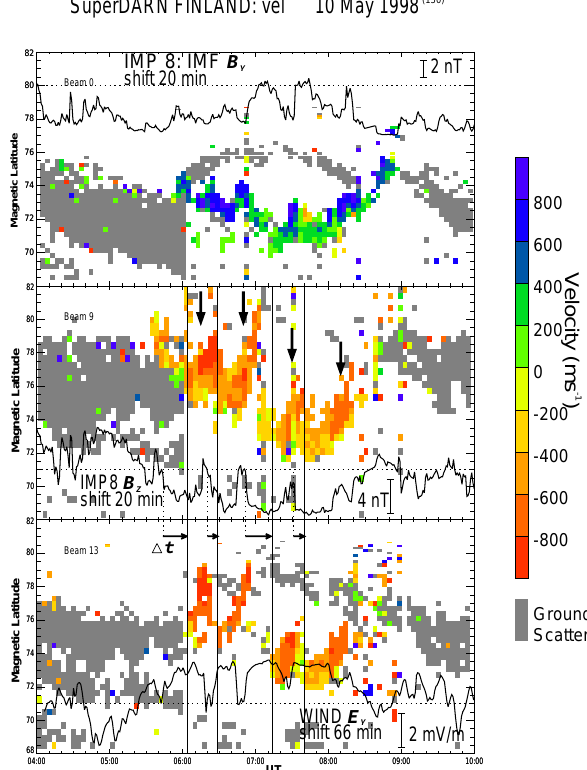
Fig. 5. The Finland radar (beams 0, 9, and 13) color-coded line-of-sight velocity showing quasi-periodic poleward progressing flow bursts (PIFs) associated with the DPY current intensifications (downward arrows from Fig. 3b). Time series of the IMP-8 IMF B Y , B Z and solar wind dawn-dusk electric field E Y that are shifted by the observed spacecraft-to-ground mean lag are superposed. The solid vertical lines show the onset times of PIFs (assumed to be signatures of the onset of reconnection at the magnetopause) and the dotted vertical lines indicate the IMF southward turning. The length of the horizontal arrow indicates the inferred delay ( 1t ) of the reconnection onset after the IMF southward turning at the mag-